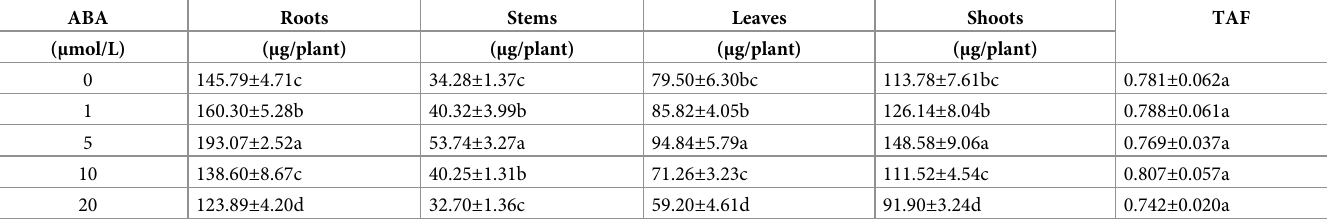
Table 6. Se extraction by P . frutescens . ABA